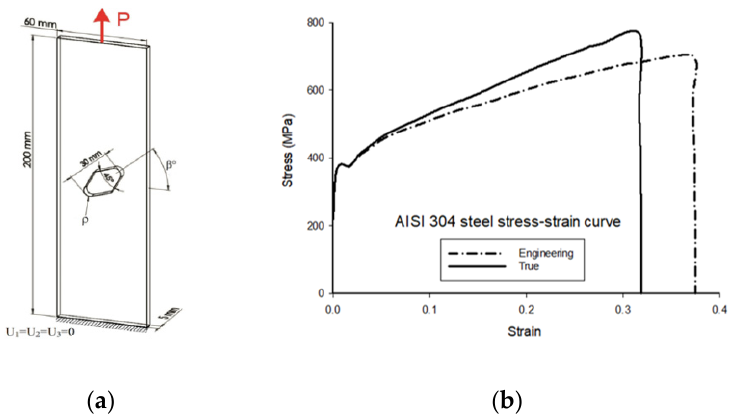
Figure 6. ( a ) Tensile rectangular specimen containing central inclined blunt V-notches of various tip radii; ( b ) the tensile stress–strain curve of the AISI 304 steel [64].